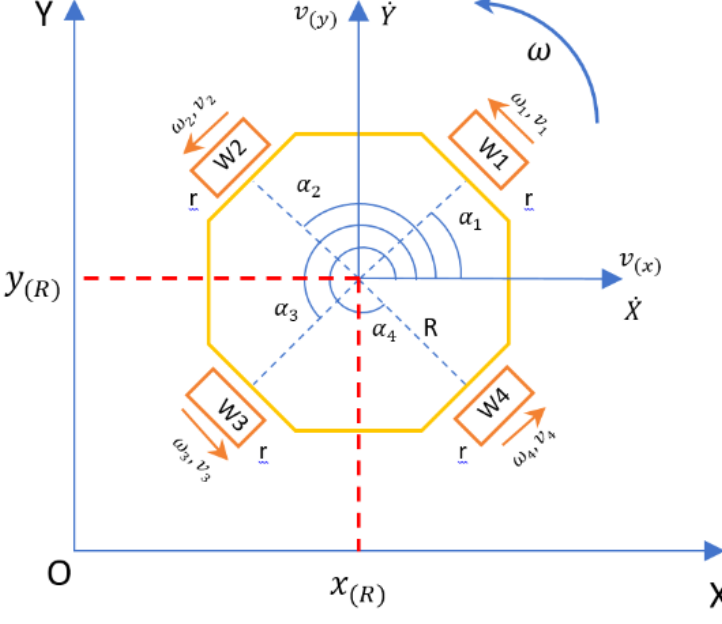
Figure 1. Wheel placement of the omnidirectional